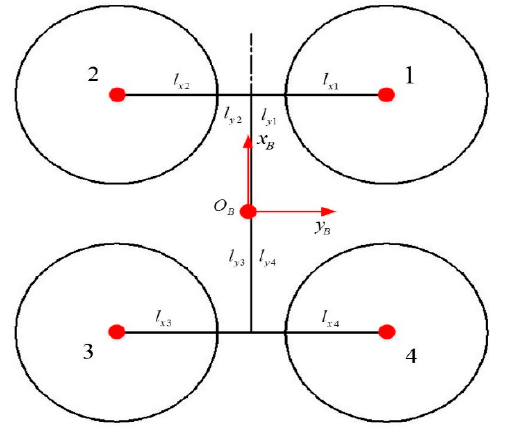
Figure 6. Quadcopter plane: simplified structure.